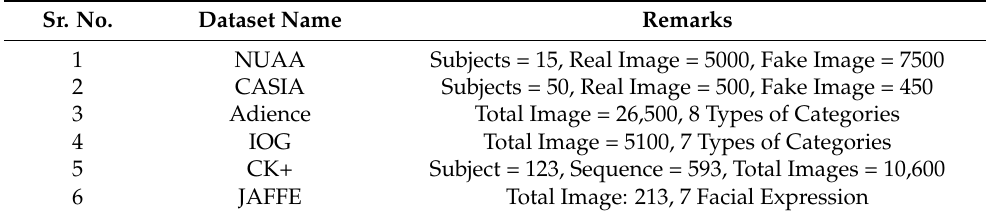
Table 4. Details of Benchmark/Standard